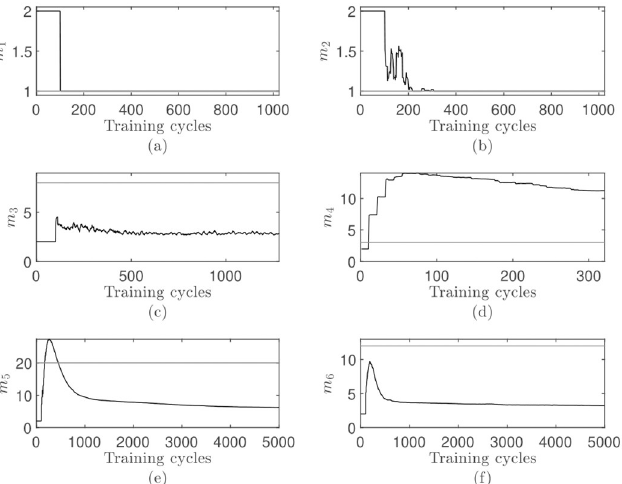
Fig 5. Visualization of the dimensionality adjustment process for the online eigenvalue-one criterion: (a-f) Adjustment process corresponds to the results in Table 2. Each data point in each time series is the mean value of all 100 repetitions. The horizontal reference line represents the optimal